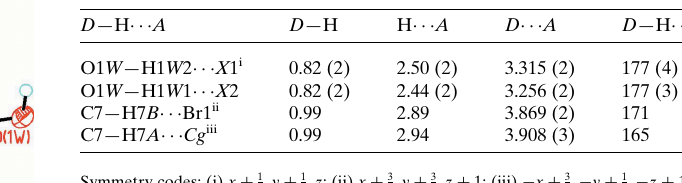
Table 1 Hydrogen-bond geometry (A˚ , (cid:4) ).